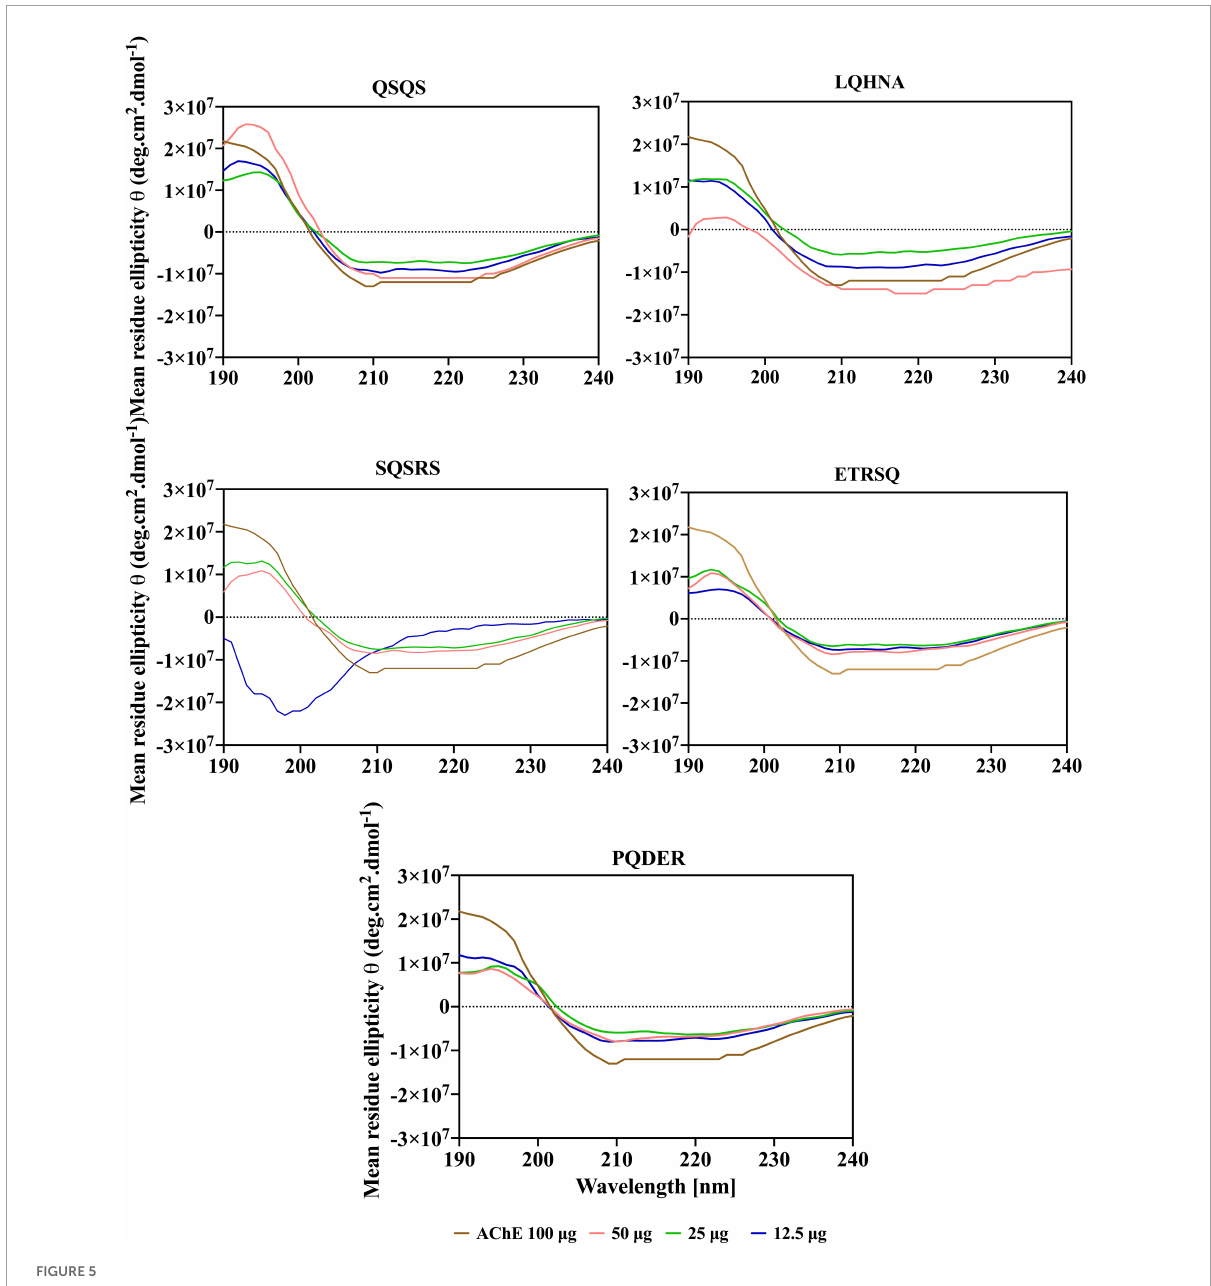
FIGURE5 Far-UV spectra of AChE in the presence of different concentrations of peptides.